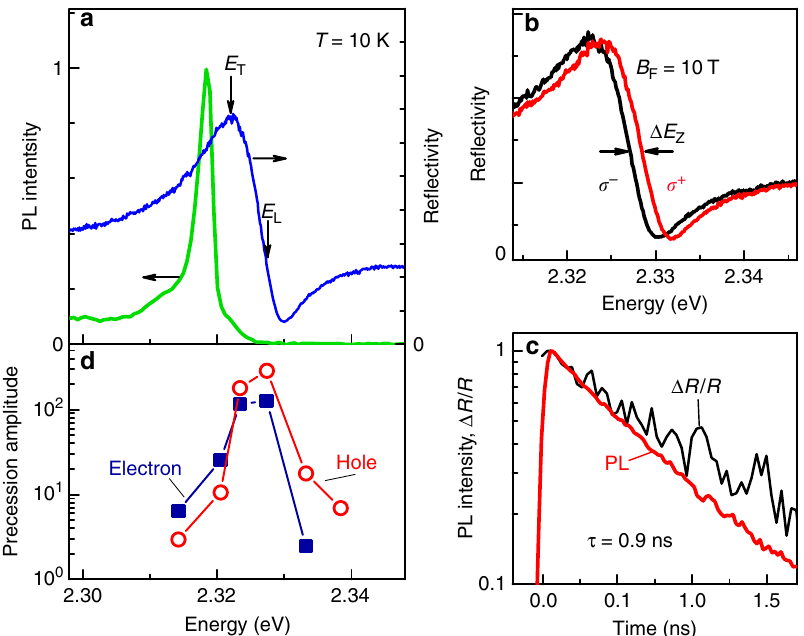
Fig. 1 Photoluminescence and re fl ectivity of CsPbBr 3 perovskite crystal. a Photoluminescence (green line, excitation energy at 2.376 eV) and re fl ectivity (blue line) spectra. Energies for longitudinal ( E L ) and transverse ( E T ) exciton-polaritons are marked by arrows. b Re fl ectivity spectra measured for opposite circular polarizations in longitudinal magnetic fi eld B F = 10 T. c Exciton recombination dynamics measured at 2.318 eV with streak-camera under nonresonant excitation (at 3.263 eV, red line) and measured under resonant excitation at 2.328 eV as the signal of differential re fl ection (black line). T = 10 K. d Spectral dependence of spin precession amplitude of electrons (solid squares) and holes (open circles) in transverse magnetic fi eld B V = 0.5 T. Source data are provided as a Source Data fi